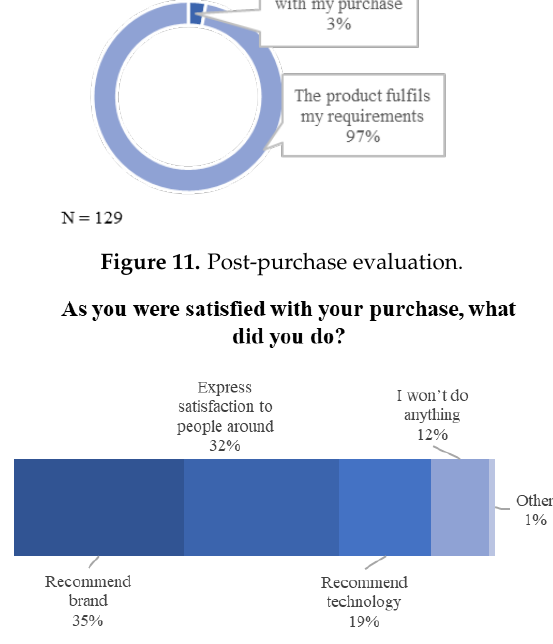
Figure 12. Post-purchase attitude in case of satisfaction.